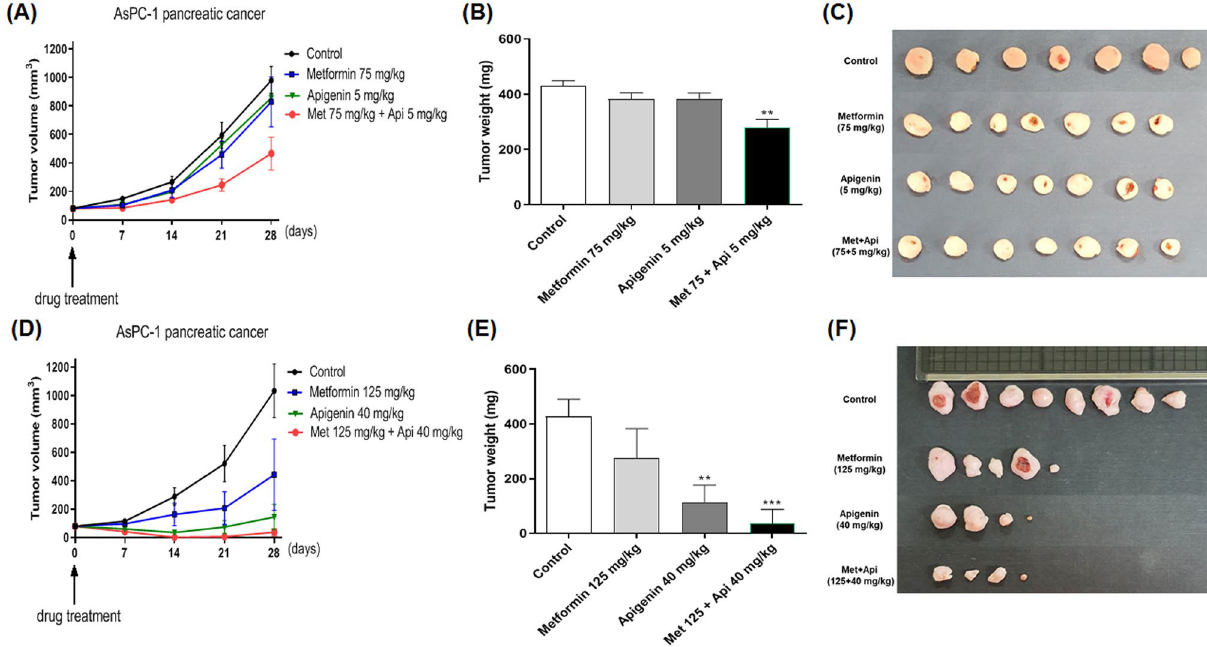
Figure 7. Effect of metformin and apigenin on tumor growth in xenograft model of nude mice. AsPC-1 (1 × 10 7 cells in 100 μl) cells were injected subcutaneously into the dorsal flank of athymic nude mice. When tumors reached a size of approximately 80 mm 3 , mice were administered orally with metformin (75 mg/kg), apigenin (5 mg/kg), or combination of two drugs in a group. In another group, mice were administered orally with metformin (125 mg/kg), apigenin (40 mg/kg) or the combination of two drugs. The drugs were administered twice a day for a total of 28 days. ( A ) and ( D ): Tumor volume was measured for up to four weeks. ( B ) and ( E ): Weights of excised tumors were measured at the end of the study. ( C ) and ( F ): Photographs of excised tumors in each group are shown. Statistical significance is indicated as ** p < 0.01, and *** p < 0.001 compared with control